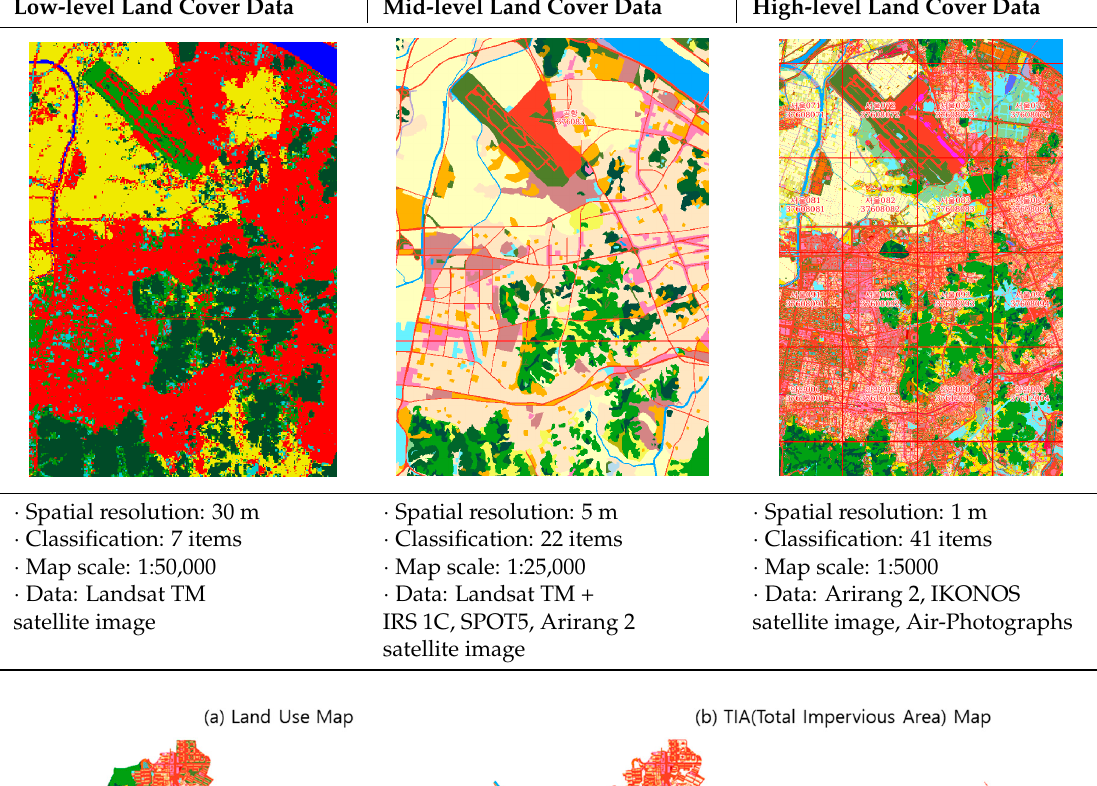
Table 1. Land cover classification (Ministry of Environment, South Korea).